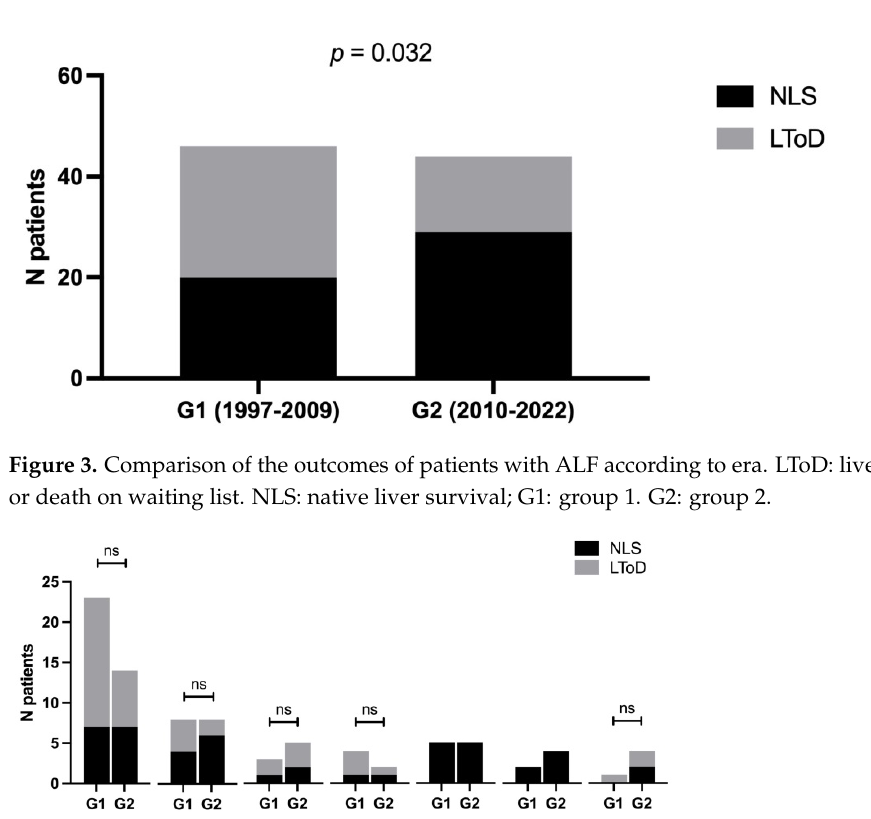
Figure 2. Kaplan–Meier native liver survival curve comparison of patients with ALF according to era. LT: liver transplant. G1: group 1. G2: group 2.